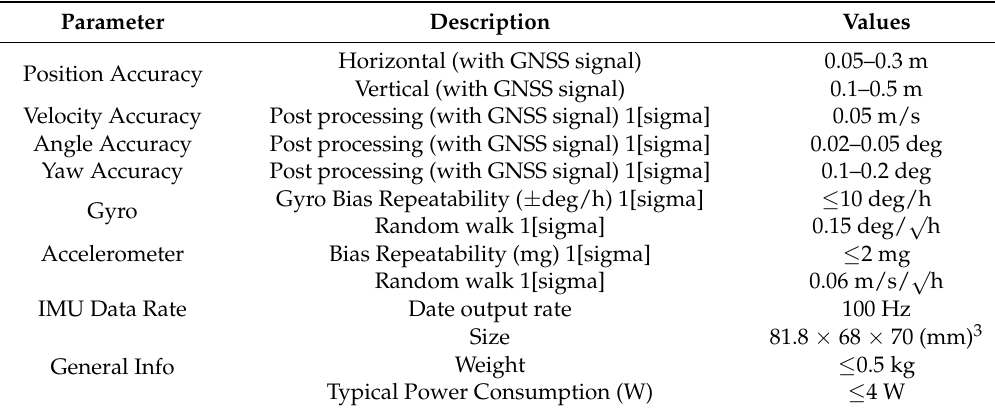
Table 2. Specific parameter description of navigation